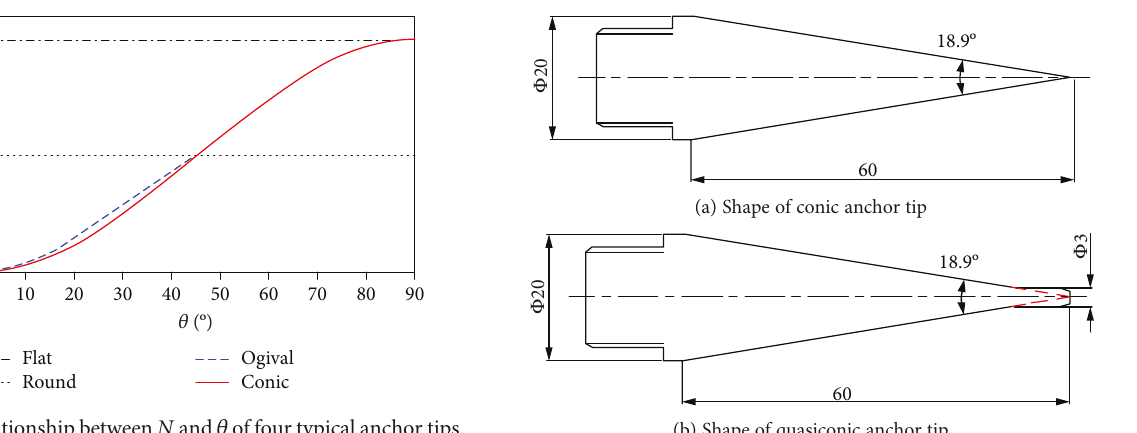
Figure 11: Relationship between N and θ of four typical anchor